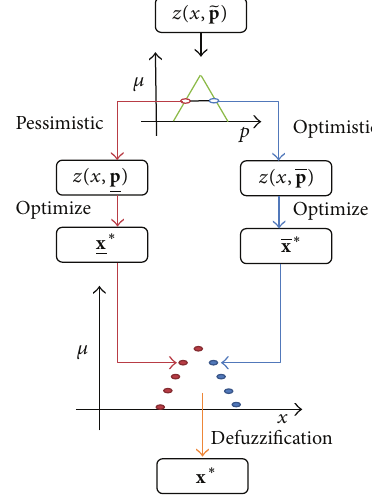
Figure 3: Dual optimization procedure